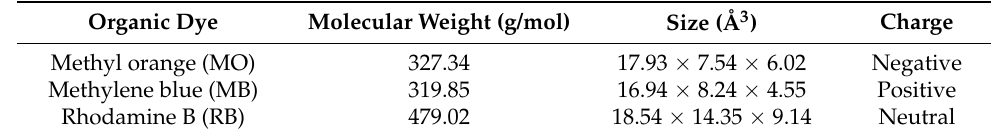
Table 2. Organic dye molecules used for evaluating nanofiltration performance of the GOM series [42]. Organic Dye